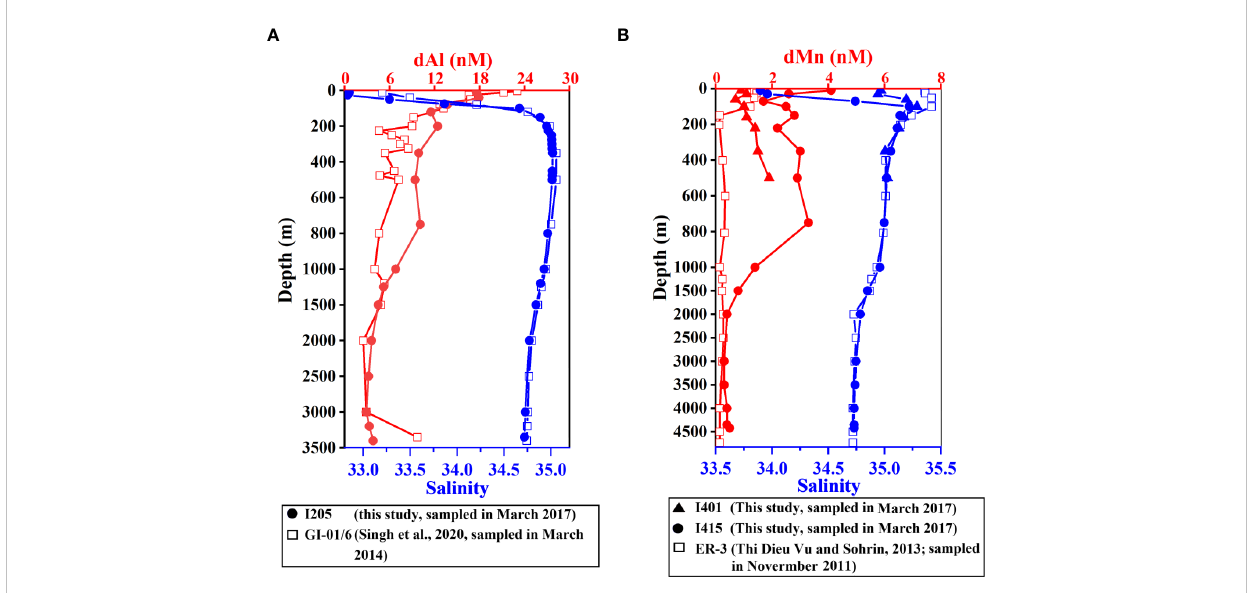
FIGURE 6 (A) Comparisons of salinity (blue) and dAl (red) at the full vertical pro fi le of dAl of Indian GEOTRACES stations GI-01/06 (hollow square, Singh et al., 2020) and I205 (dot, this study). (B) Comparisons of salinity (blue) and dMn (red) at Japanese GEOTRACES stations ER-3 (hollow square, Thi Dieu Vu and Sohrin, 2013), I401 (triangle, this study), and I415 (dot, this study). dAl, dissolved aluminum; dMn, dissolved